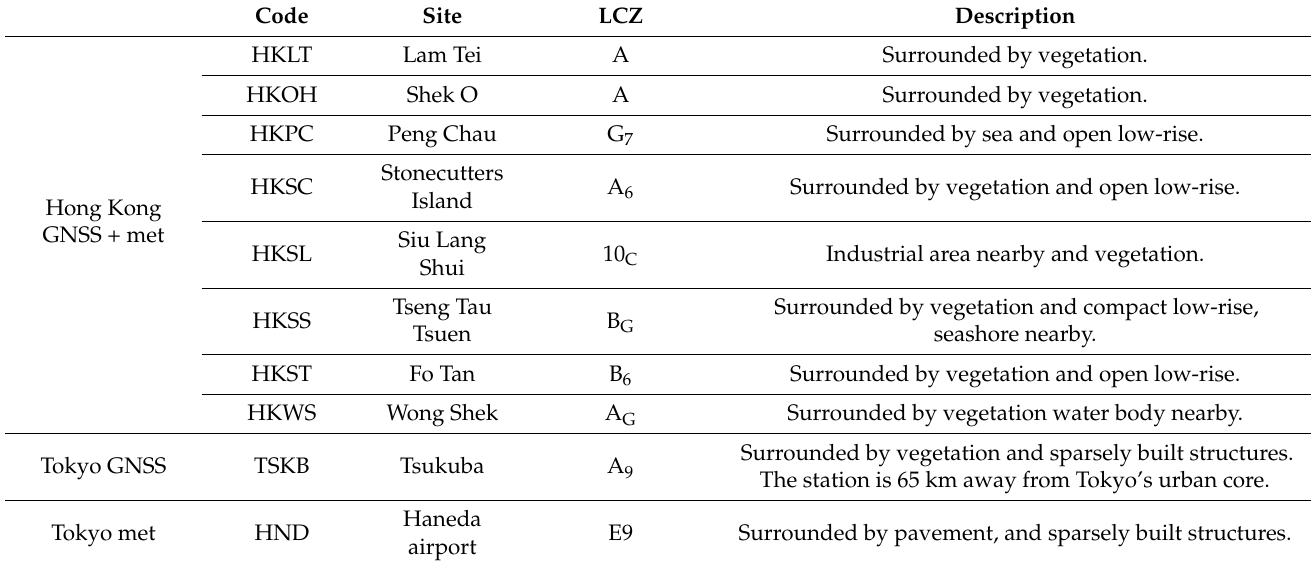
Table 3. GPS and meteorological stations in rural-like areas in Hong Kong and